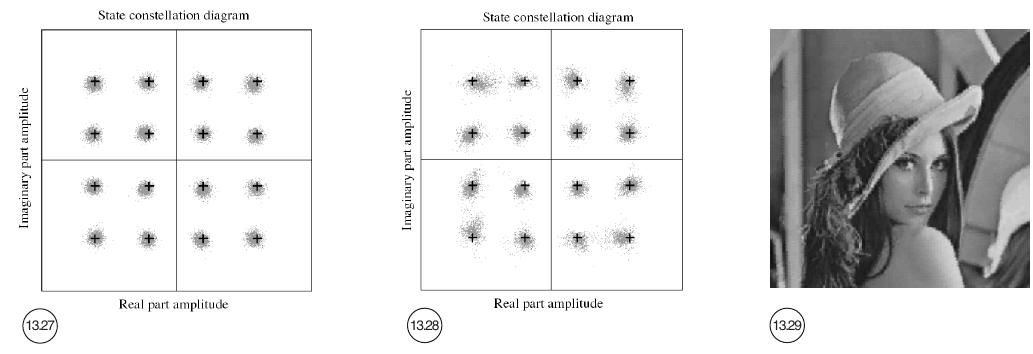
Fig. 13.27. Constellation at the output of the spatial filter. Fig. 13.28. State constellation diagram (6.7 MHz). Fig. 13.29. Original transmitted